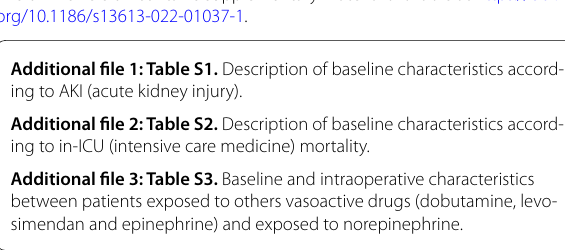
simendan and epinephrine) and exposed to norepinephrine.